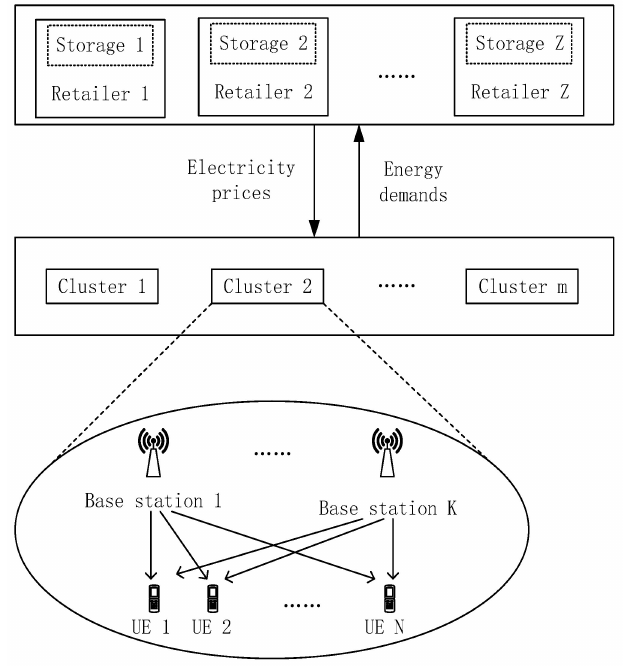
Figure 1. The system